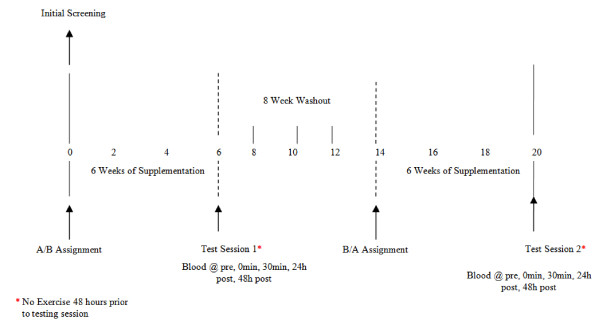
Study timeline to investigate the effects of EPA/DHA on resting and exercise-induced inflammation and oxidative stress.